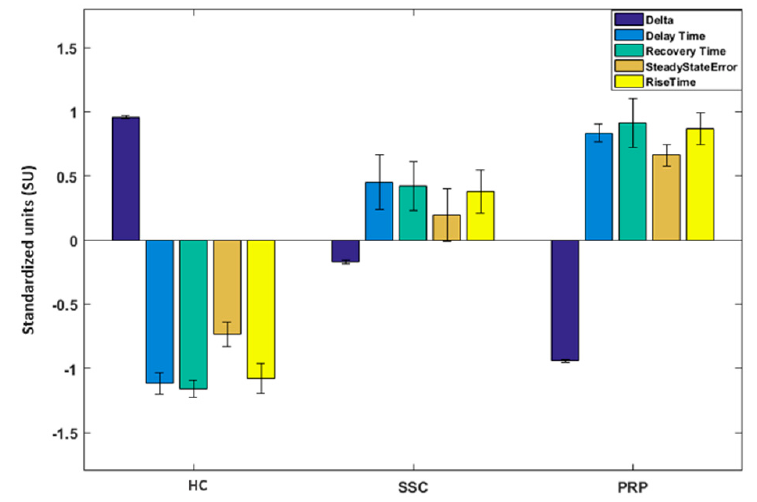
Figure 7. Group average values and the related standard deviation of each feature (z ‐ score nor ‐ malized) employed for the cold challenge procedure (CCP) analysis. The measurement units are reported as standardized units since the features shown are z ‐ score normalized.